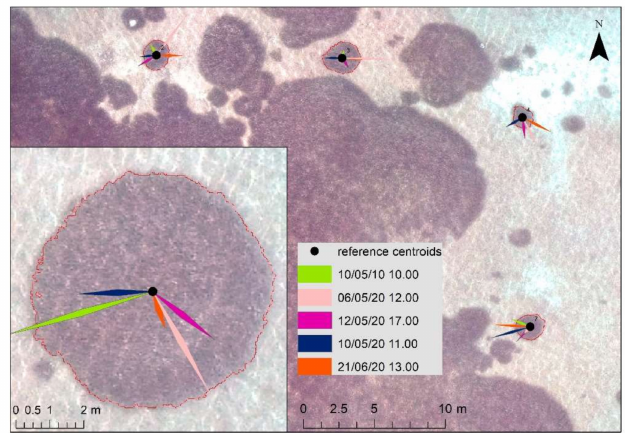
Figure 7. Error estimates of the centroid positions. The features in different colours represent the distances of the calculated centroids from the reference centroids and the error directions. (Table 5, Appendix A). Note: The actual distances have been multiplied by five for the